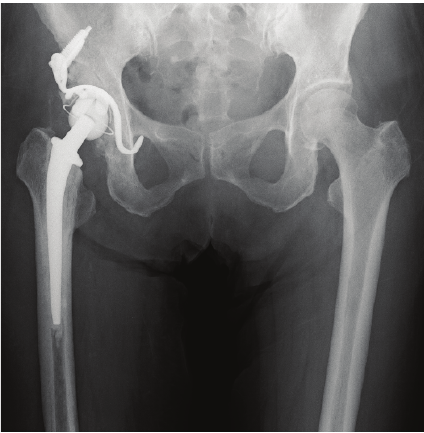
Figure 3: The femoral head is transplanted as a bone graft to the bone defect of the acetabulum, a KT plate is placed on the acetabulum, and cemented THA is